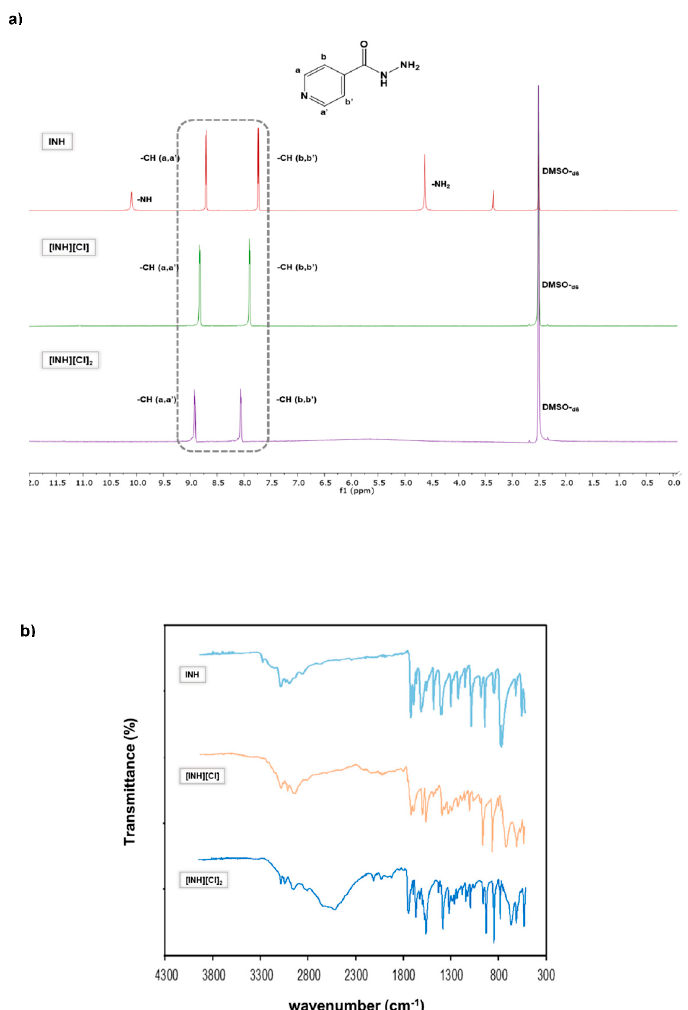
Figure 1. Characterization of mono and diprotonation of INH with counterion chloride. ( a ) 1 H-NMR spectra of INH (top), [INH][Cl] (middle) and [INH][Cl] 2 . ( b ) FTIR-ATR spectra of INH (top), [INH][Cl] (middle) and [INH][Cl] 2 .